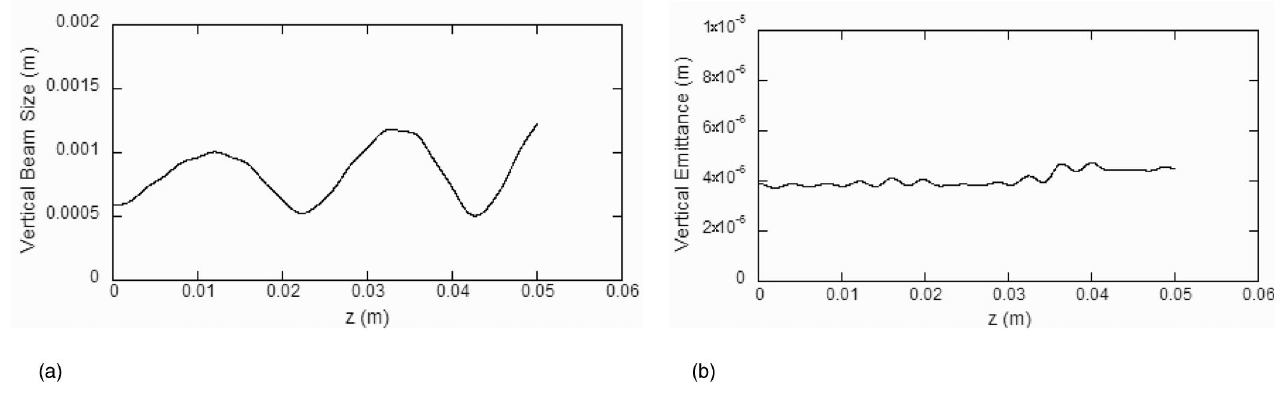
FIG. 2. (a) Vertical beam size versus axial distance for a 2 = 3 wiggler, 1 = 3 PPM field split. (b) Vertical emittance versus axial